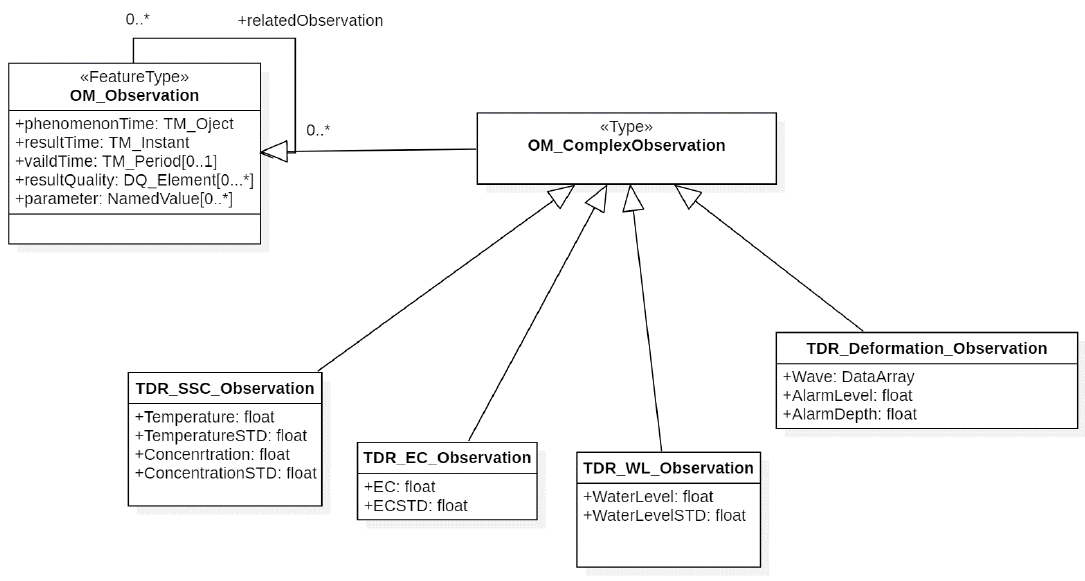
Figure 7. Class diagram of TDR OM_ComplexObservation conceptual model.